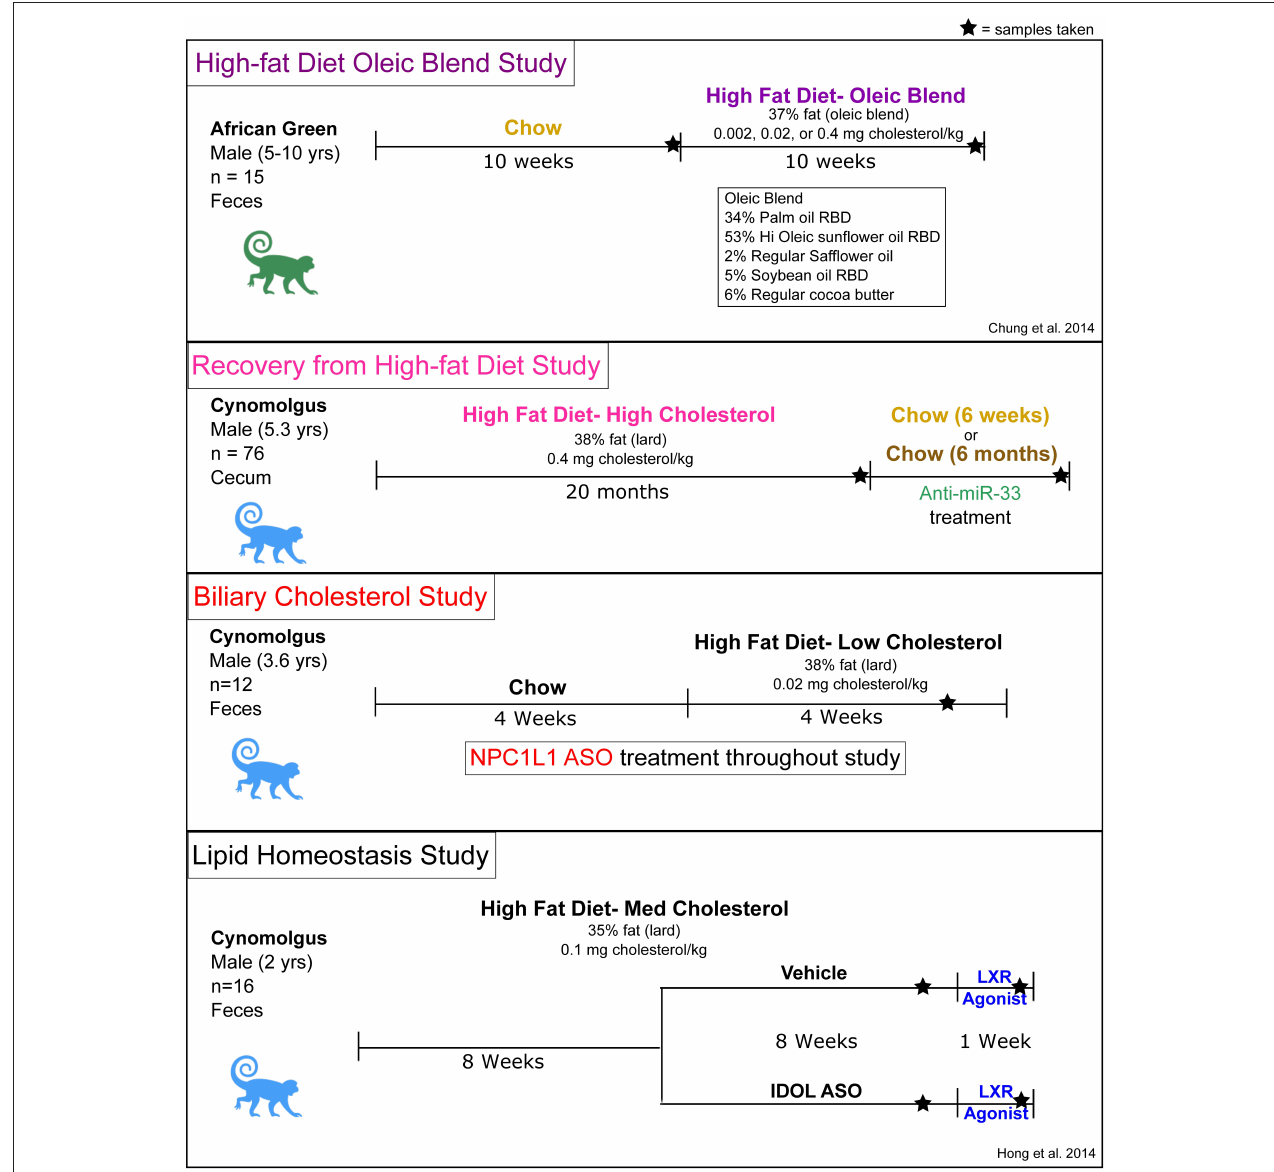
FIGURE 1 | Overview of study designs, treatments, and diet compositions.